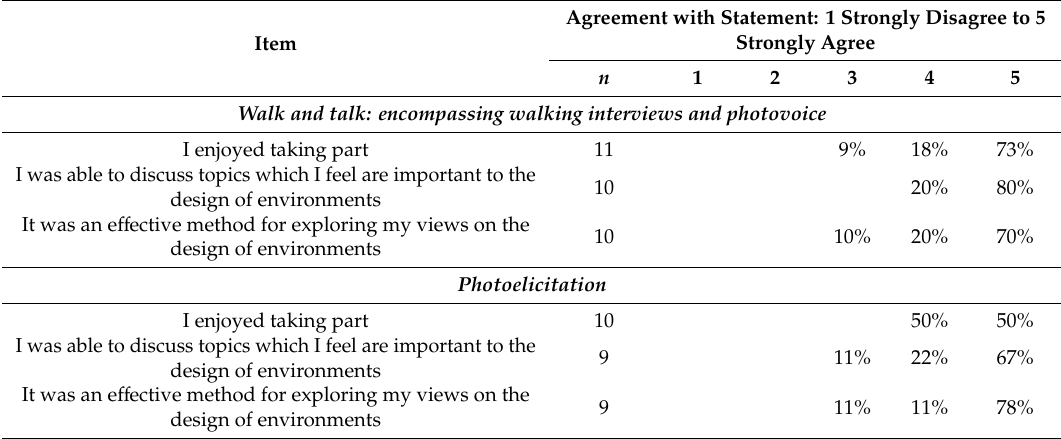
Table 3. Central Manchester co-design workshop: participant perspectives on engagement